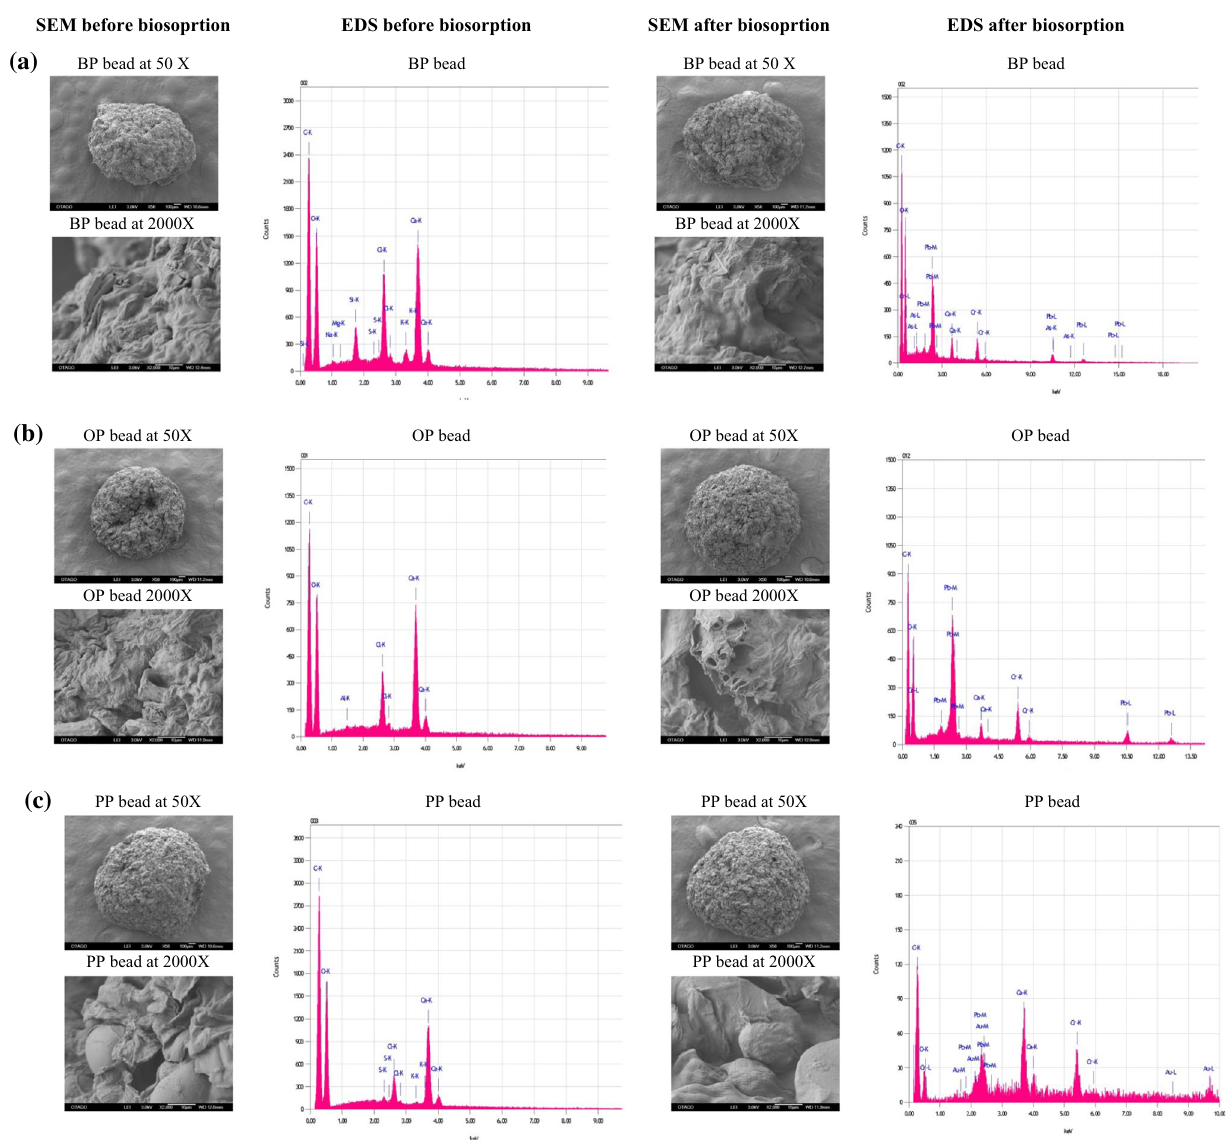
Fig. 1 SEM–EDS of FVP beads before and after biosorption. One bead was incubated in a cocktail solution containing all seven ions each at 0.1 mgL-1, pH 7.0, 25 °C with continuous shaking at 250 rpm for 10 h. a BP bead, b OP bead and c PP